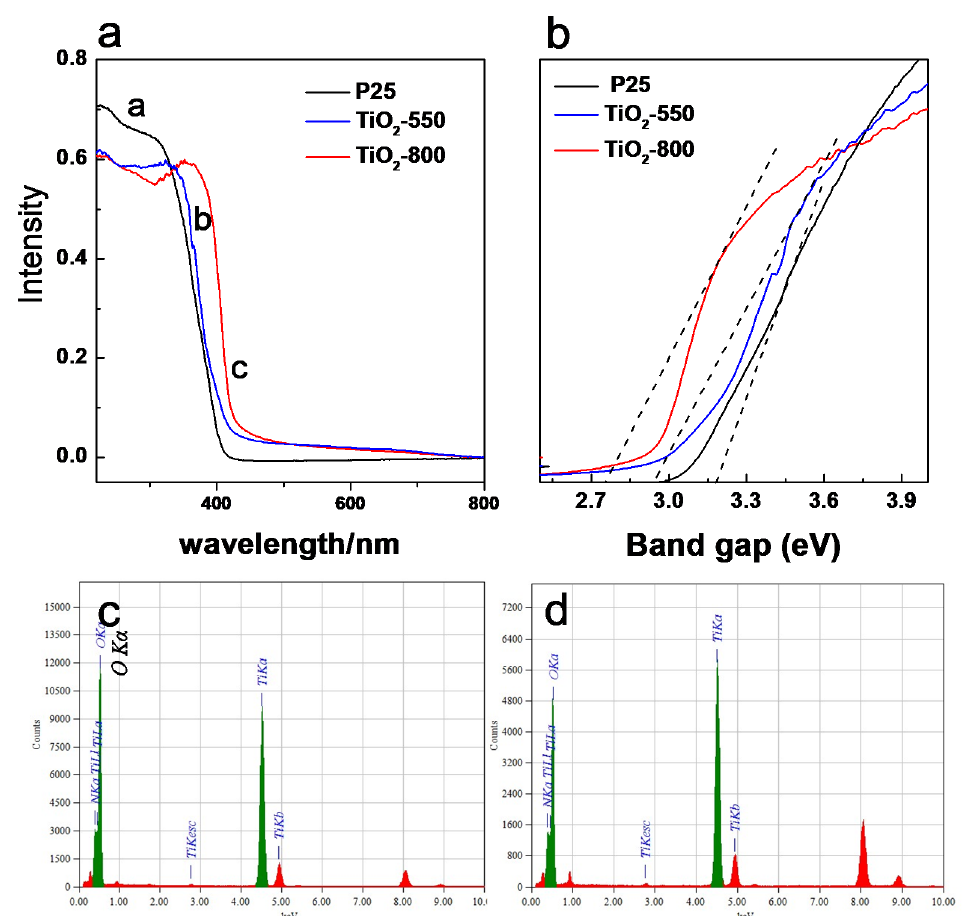
Figure 6. ( a ) UV-vis spectra of TiO 2 samples, ( b ) calculated according to the formula α h ν = A( h ν − Eg) n/2 , ( c , d ) EDS spectra for TiO 2 -550 and TiO 2 -800.